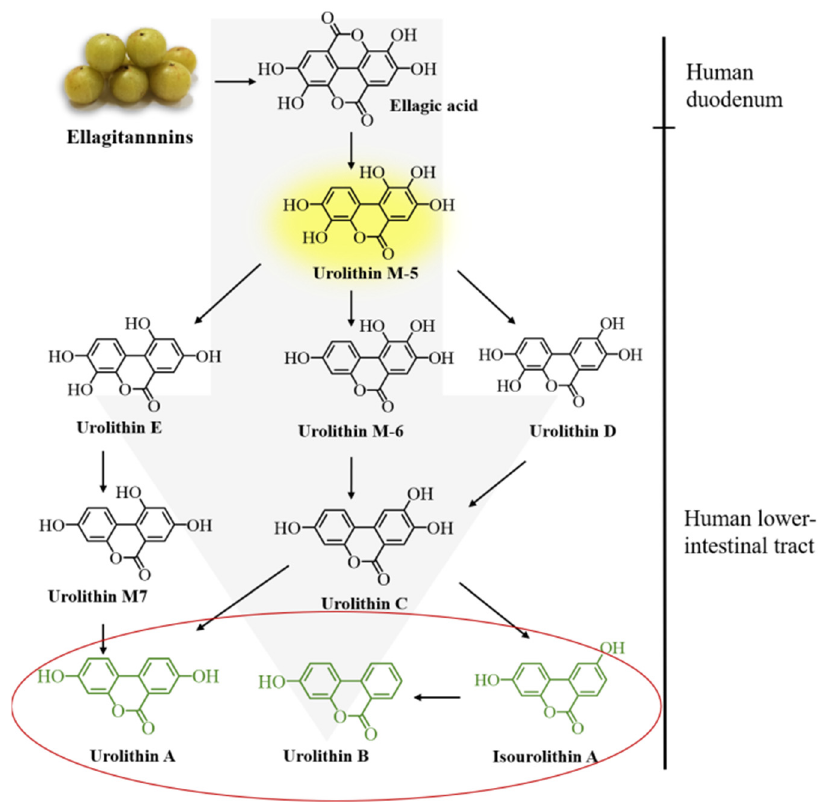
Figure 3. The catabolic pathway of ellagitannin to urolithin [143].